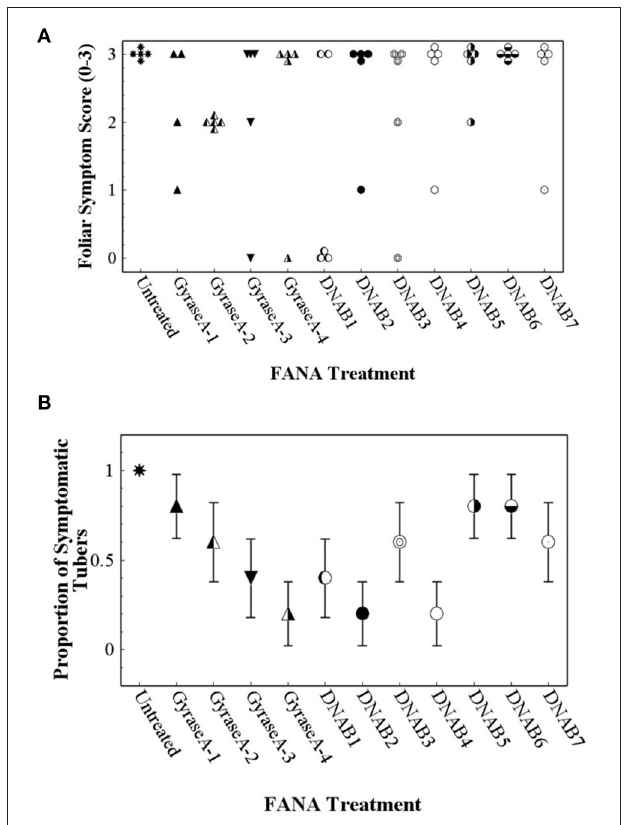
FIGURE 8 | Foliar symptom score of “0” (no symptoms) to “3” (severe leaf yellowing) (A) and proportion of seed tubers exhibiting zebra chip disease (B) observed in potato plants 7 weeks after confining CLso-infected potato psyllids to plants, and 6 weeks after the initial treatment with water (untreated) or FANA treatments (A) . Error bars represent ± SE; there is no error bar for the untreated control because all plants exhibited severe yellowing of leaves.